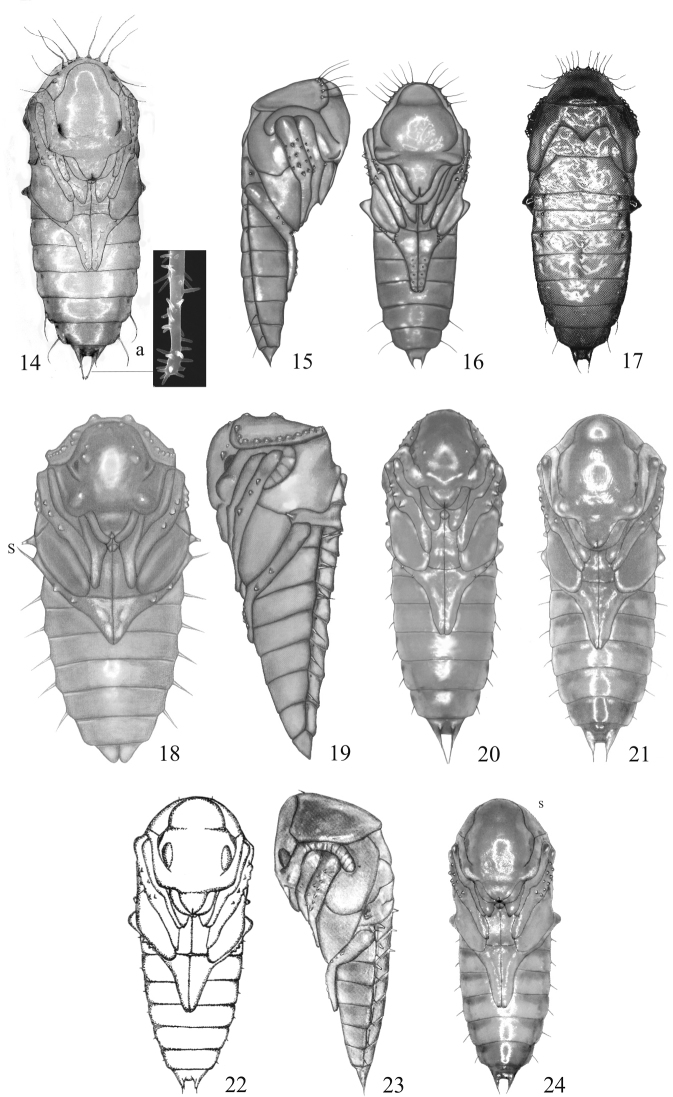
Pupae; dorsal aspect (17), lateral aspect (15, 19, 23), ventral aspect (14, 16, 18, 20, 21, 22, 24), accessories of terminal prolongation (14a) 14, 14aGabrius
appendiculatus15, 16Hesperus
rufipennis17Bisnius
fimetarius18, 19Atanygnathus
terminalis20Heterothops
praevius21Erichsonius
cinerascens22Quedius
fumatus23Q.
cinctus24Q.
microps.